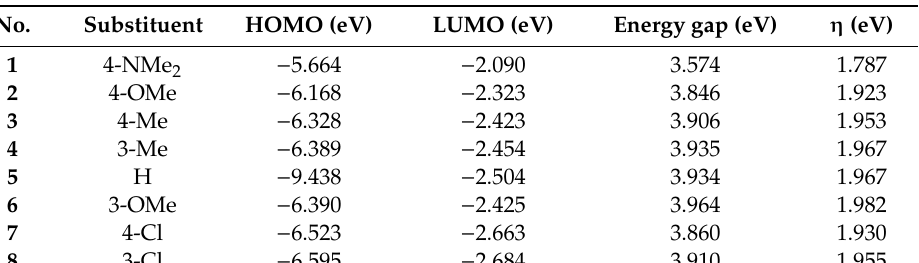
Table 4. The values of hardness ( η ), energy gap, and energies of HOMO and LUMO orbitals were estimated for considered molecules.